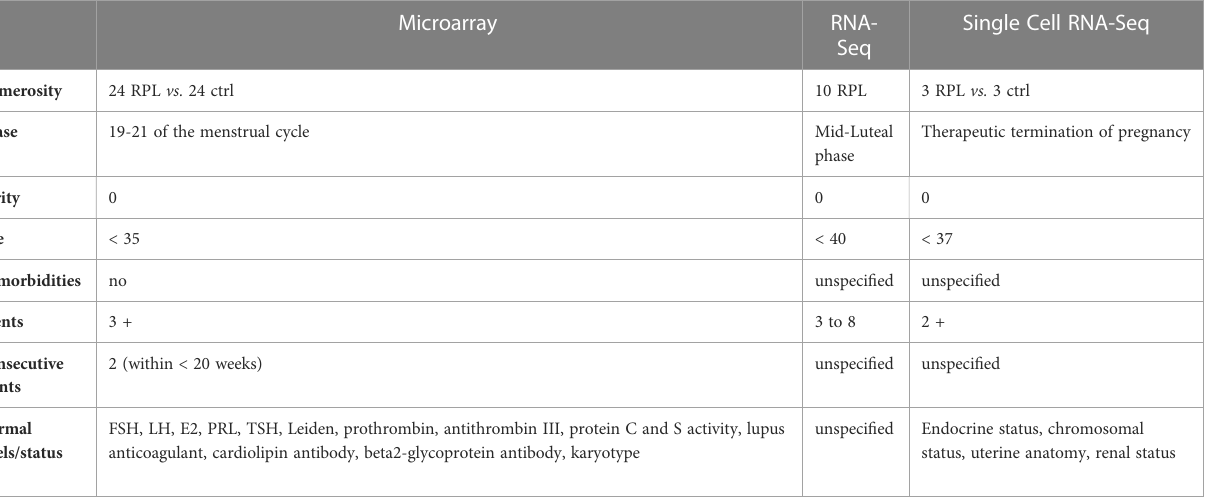
TABLE 3 Cohort parameters